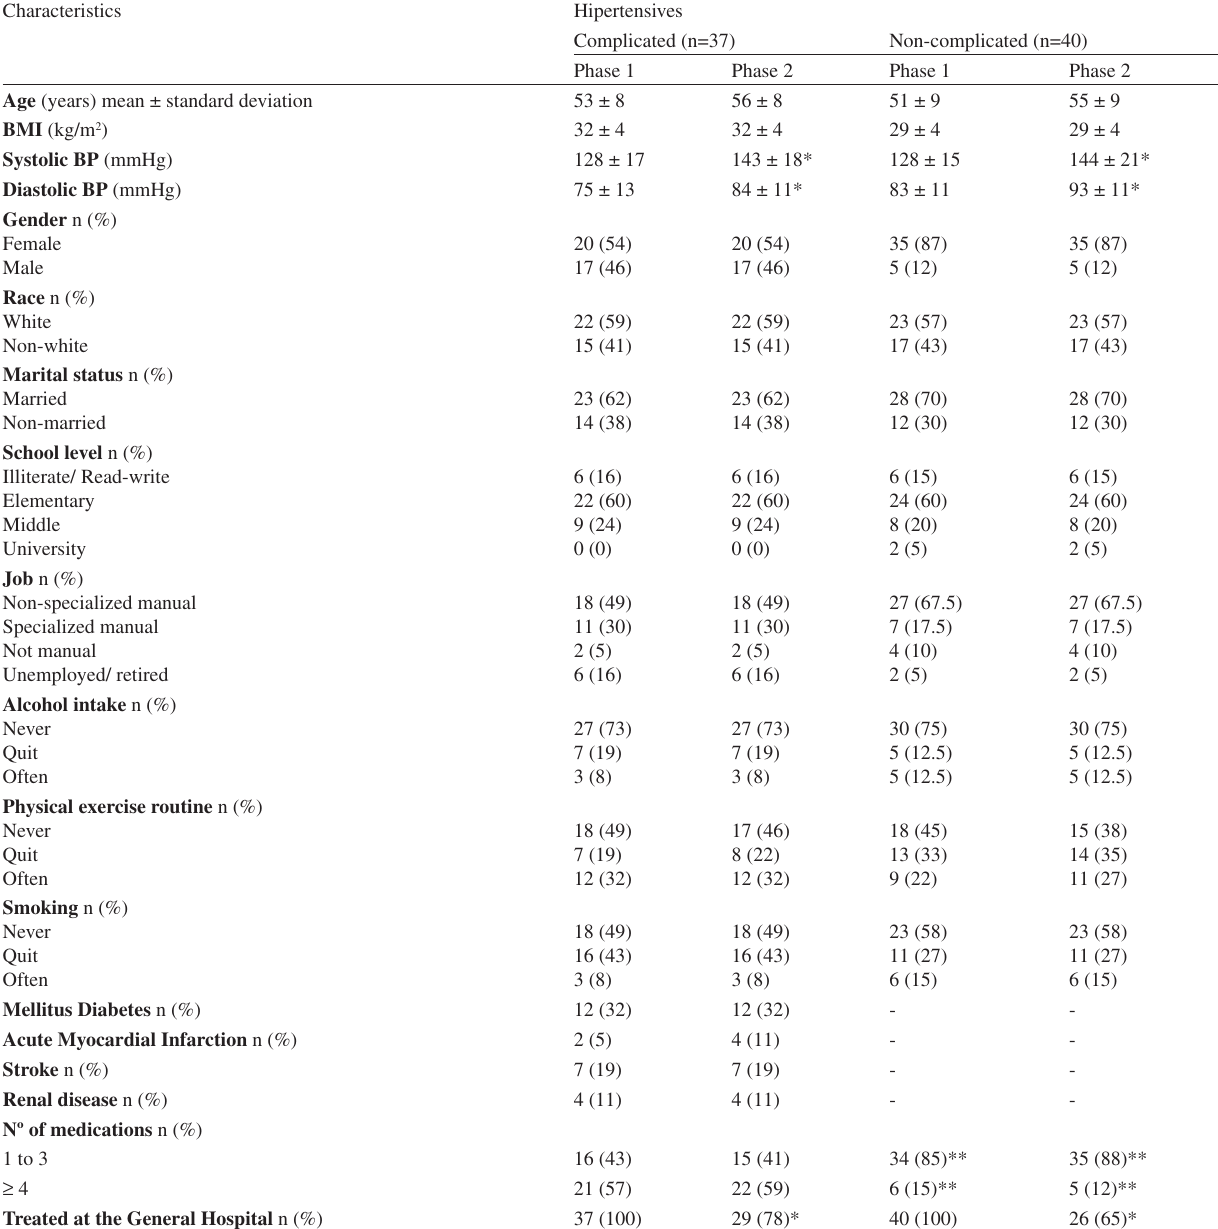
Table 1 - Age, gender, race, school level, marital status, job, body mass index (BMI), life habits, blood pressure, and number of medications taken of hypertensive patients with and without complications Characteristics